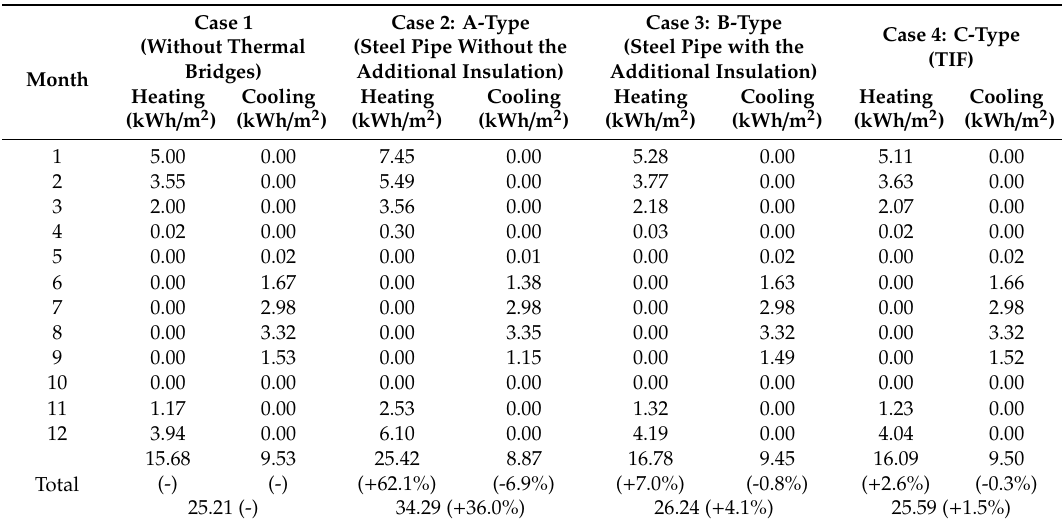
Table 8. Annual heating and cooling energy